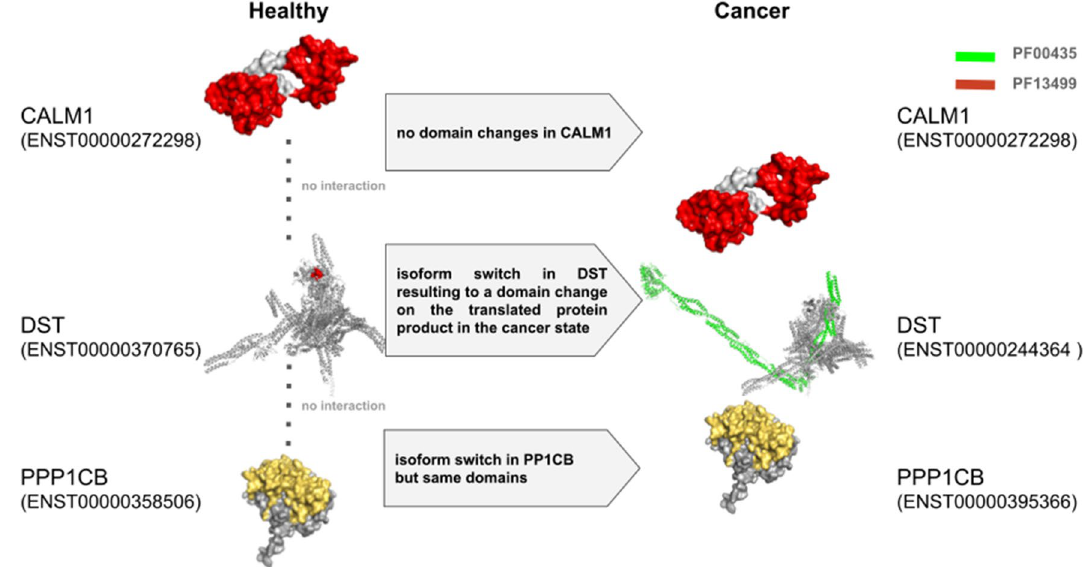
Figure 2. A correct version of the original Figure 3. An example showing the consequences of domain changes between the cancer state and healthy state in patients diagnosed with BRCA. The protein structures of both (P0DP23) CALM1 and (P62140) PP1CB were obtained from PDB while those of DST were modelled using the ensemble transcript sequences in SWISS-MODEL and visualized in PyMol. Following an isoform switch from ENST00000370765 (in healthy) to ENST00000244364 (in cancer), the protein Q03001 ( DST ) gained the domain PF13499. The consequence is the gain of interactions with the genes PPP1CB and CALM1